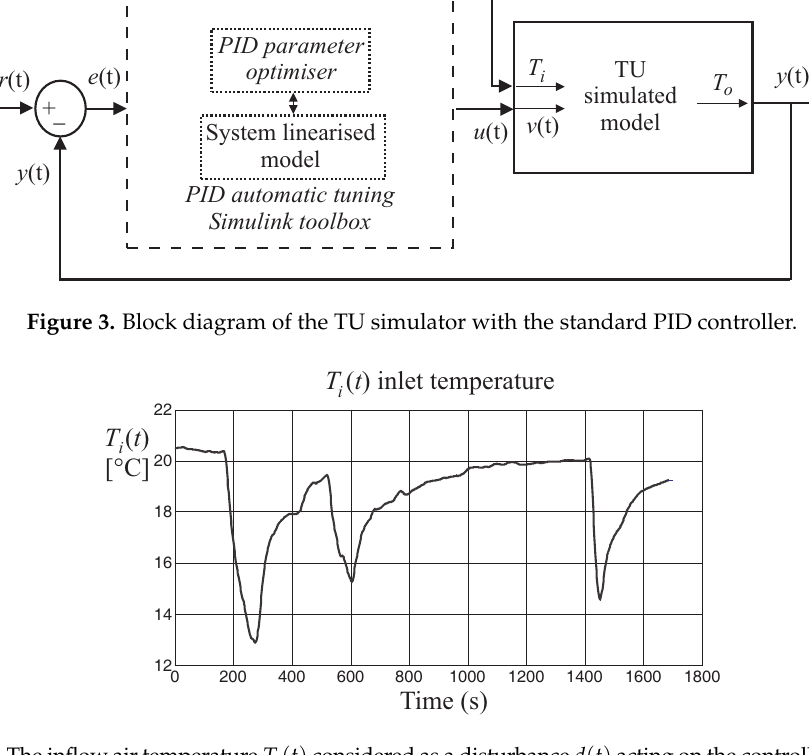
The proportional,